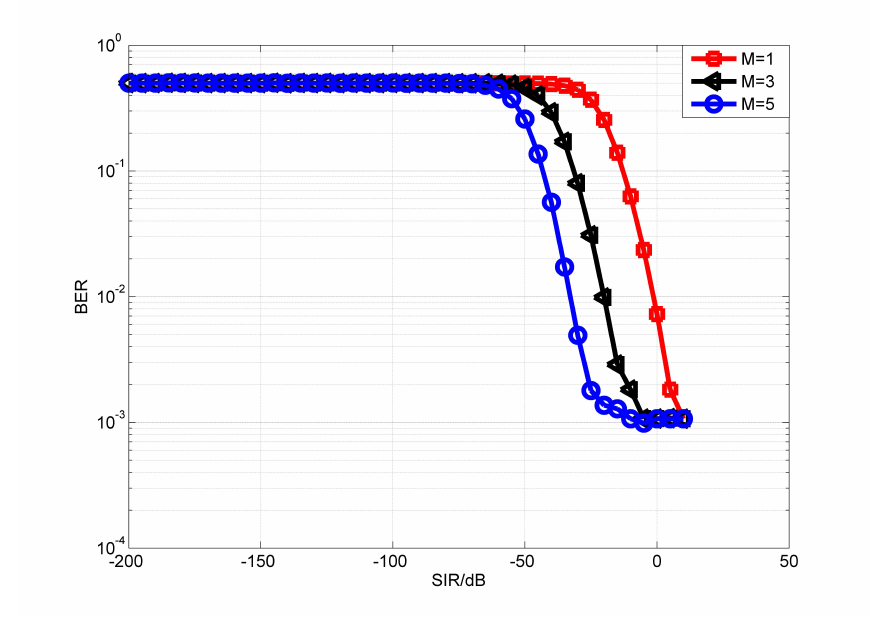
Figure 7. BER performance of OPRLS with quantization noise.